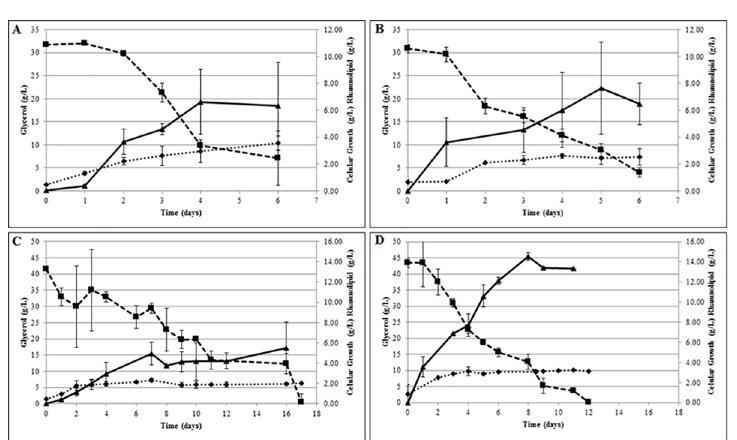
Fig 3. Kinetic of rhamnolipid production. Wild type and recombinantstrains were used at cultives under MSP media in two different C/N ratios. Glycerol was used at carbon source and sodium nitrate as nitrogen source. RML production and glycerol consumption was accessed by liquidchromatography. Generaldata on cell (rhombus), rhamnolipid (triangle), and glycerol(square) concentrations (g/L) are shown over time for A) wild-typestrain ( P . aeruginosa PAO1) at C/N = 17.5; B) modifiedstrain ( P . aeruginosa -estA) at C/N = 17.5; C) wild-typestrain ( P . aeruginosa PAO1) at C/N = 83.2; D) modifiedstrain ( P . aeruginosa -estA) at C/N = 83.2.